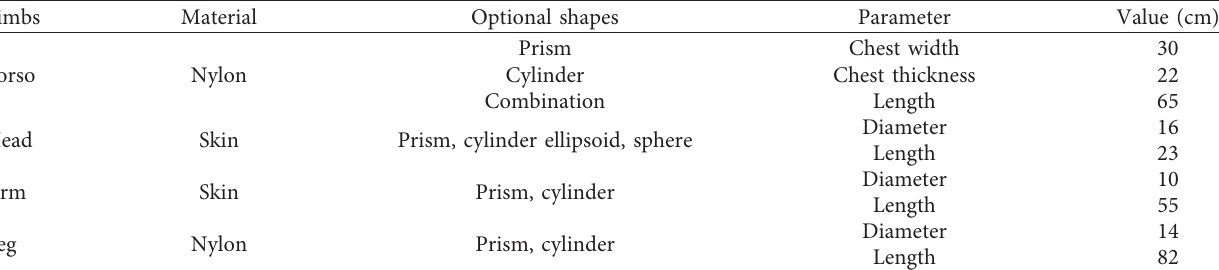
Table 2: Parameters of the human body